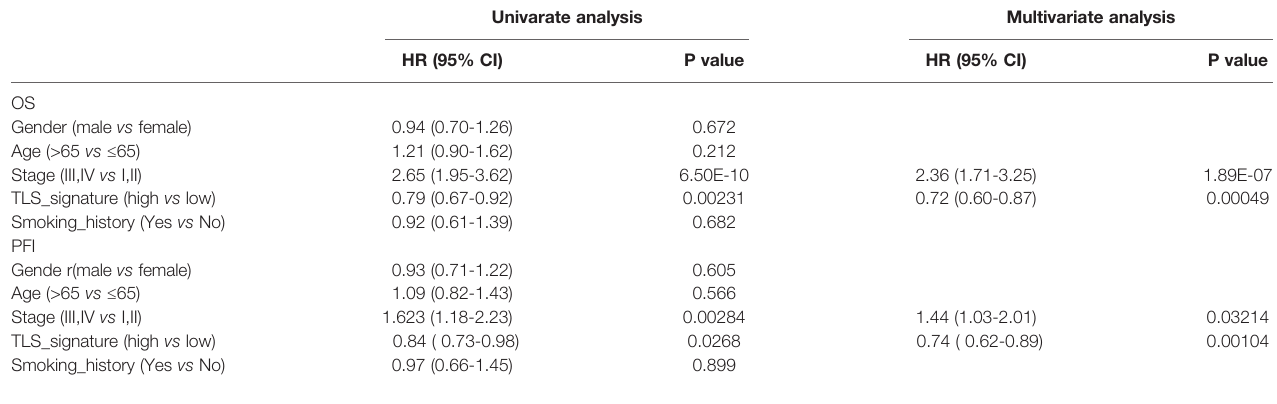
TABLE 1 | Univariate and multivariate cox analyses of prognosis of LUAD patients in the TCGA